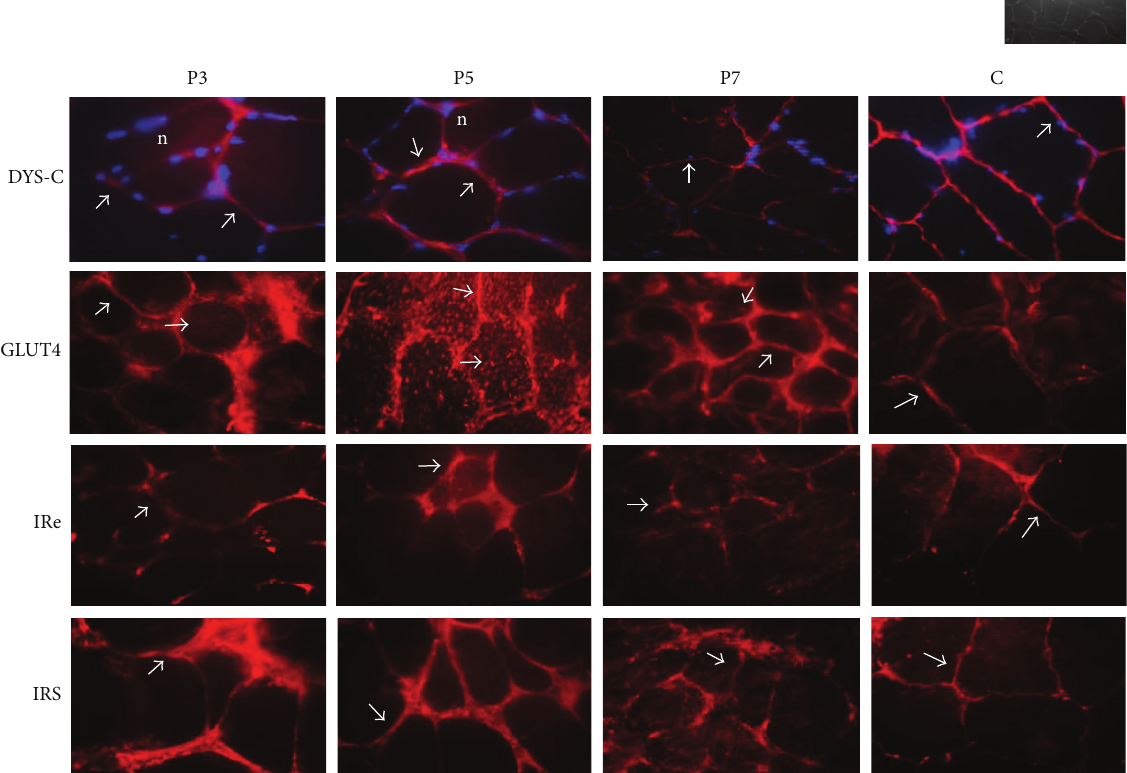
Figure 4: Immunofluorescence analysis of dystrophin (DYS), insulin receptor (IRe), insulin receptor substrate (IRS), and glucose transporter 4 (GLUT4) of healthy individuals and DMD/BMD patients. Immunostaining demonstrated semiabsence of dystrophin on the muscle fibers of the patients. DYS-C, GLUT4, IRe, and IRS are stained in red (arrows) and nuclei are stained in blue (n). Negative control omitted the primary antibody.